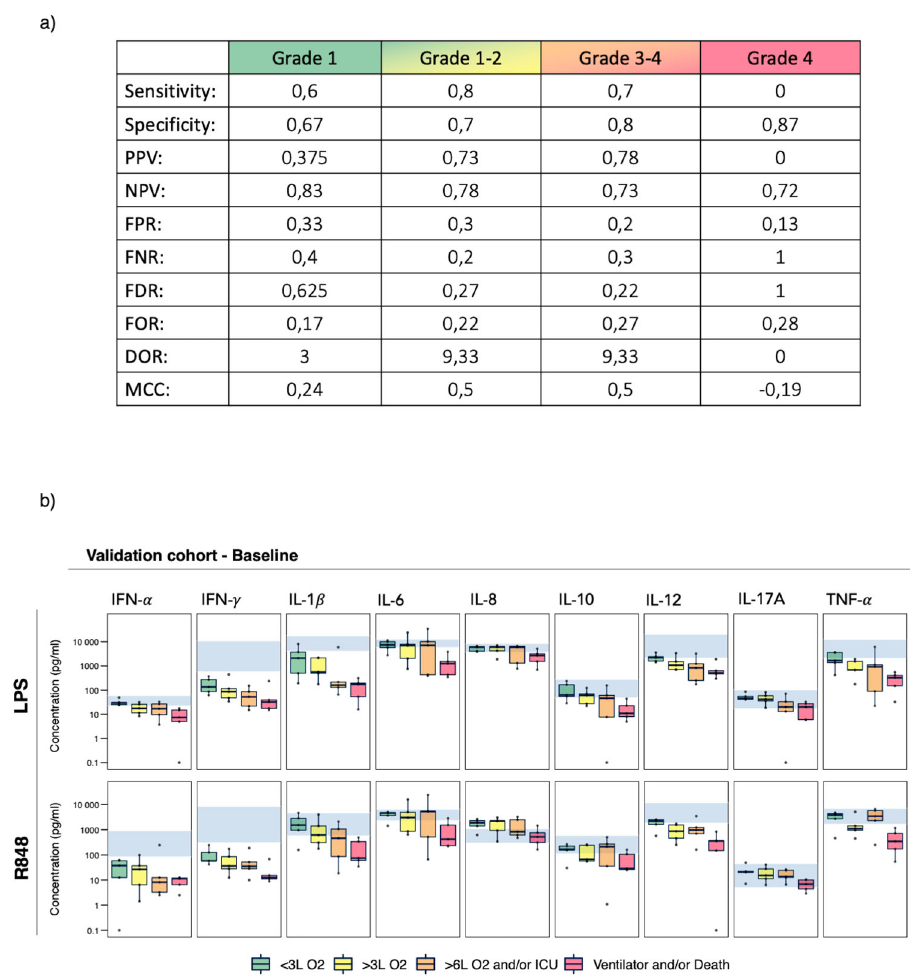
Fig. 6 Validation of the immune response signature in a separate cohort. The LPS + R848 model was validated on a separate cohort of hospitalized COVID-19 patients ( n = 20, 5 in each peak severity group). a Sensitivity/recall, speci fi city, false positive rate (FPR), false negative rate (FNR), positive predictive value (PPV) /precision, negative predictive value (NPV), false discovery rate (FDR), false omission rate (FOR), diagnostic odds ratio (DOR), and Mathew ’ s correlation coef fi cient (MCC) are presented for predicting severity grade 1 alone, grade 1 – 2, grade 3 – 4, and grade 4 alone. b Cytokine levels in response to LPS and R848 based on baseline data from the validation cohort ( n = 20). Patients are grouped based on future peak severity: Grade 1 ( n = 5, green), Grade 2 ( n = 5, yellow), Grade 3 ( n = 5, orange), Grade 4 ( n = 5, red). Box edges represent the 25 th and 75 th percentiles, and whiskers extend towards the most extreme values but no further than ± 1.5 times the interquartile range from the hinge. Hollow dots beyond whiskers represent outliers. Solid dots represent individual measurements. Blue shaded areas represent the normal reference interval. Cytokine concentration levels and immune cell subset counts are presented on a log 10 y-axis. LPS lipopolysaccharide, R848 resiquimod, IFN interferon, IL interleukin, TNF tumor necrosis factor, L O2 liters/ minute of oxygen supply, ICU intensive care